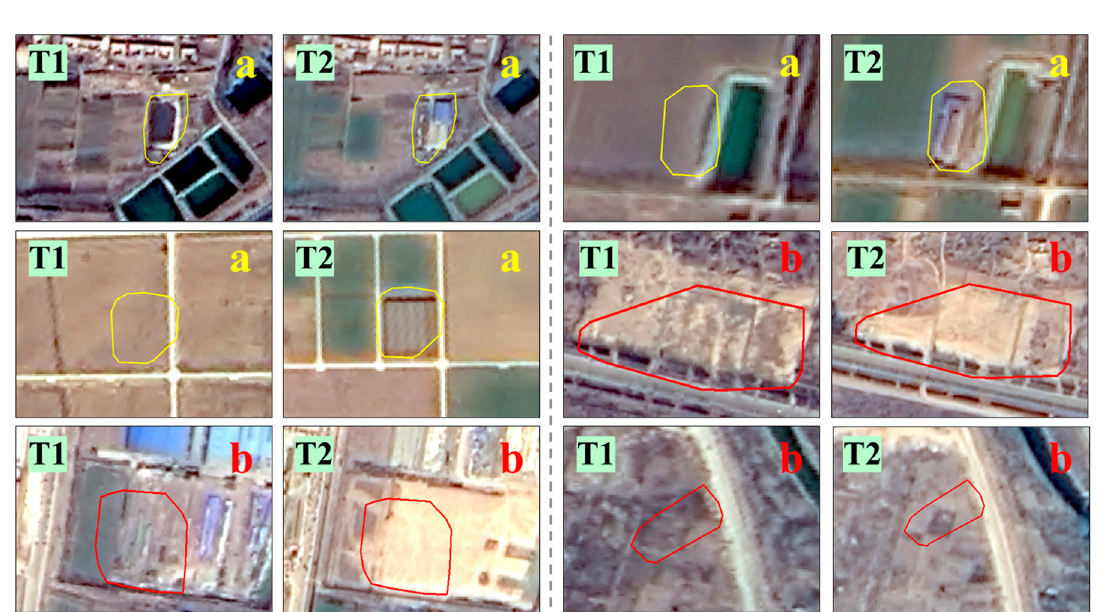
Figure 11. Examples of different classification results between 14-feature SVM and 8-feature SVM. ( a , b ) represent different examples enumerated. T1 and T2 represent pre-temporal and post-temporal images. Table 5. Accuracy assessment for 8-feature SVM classifier.